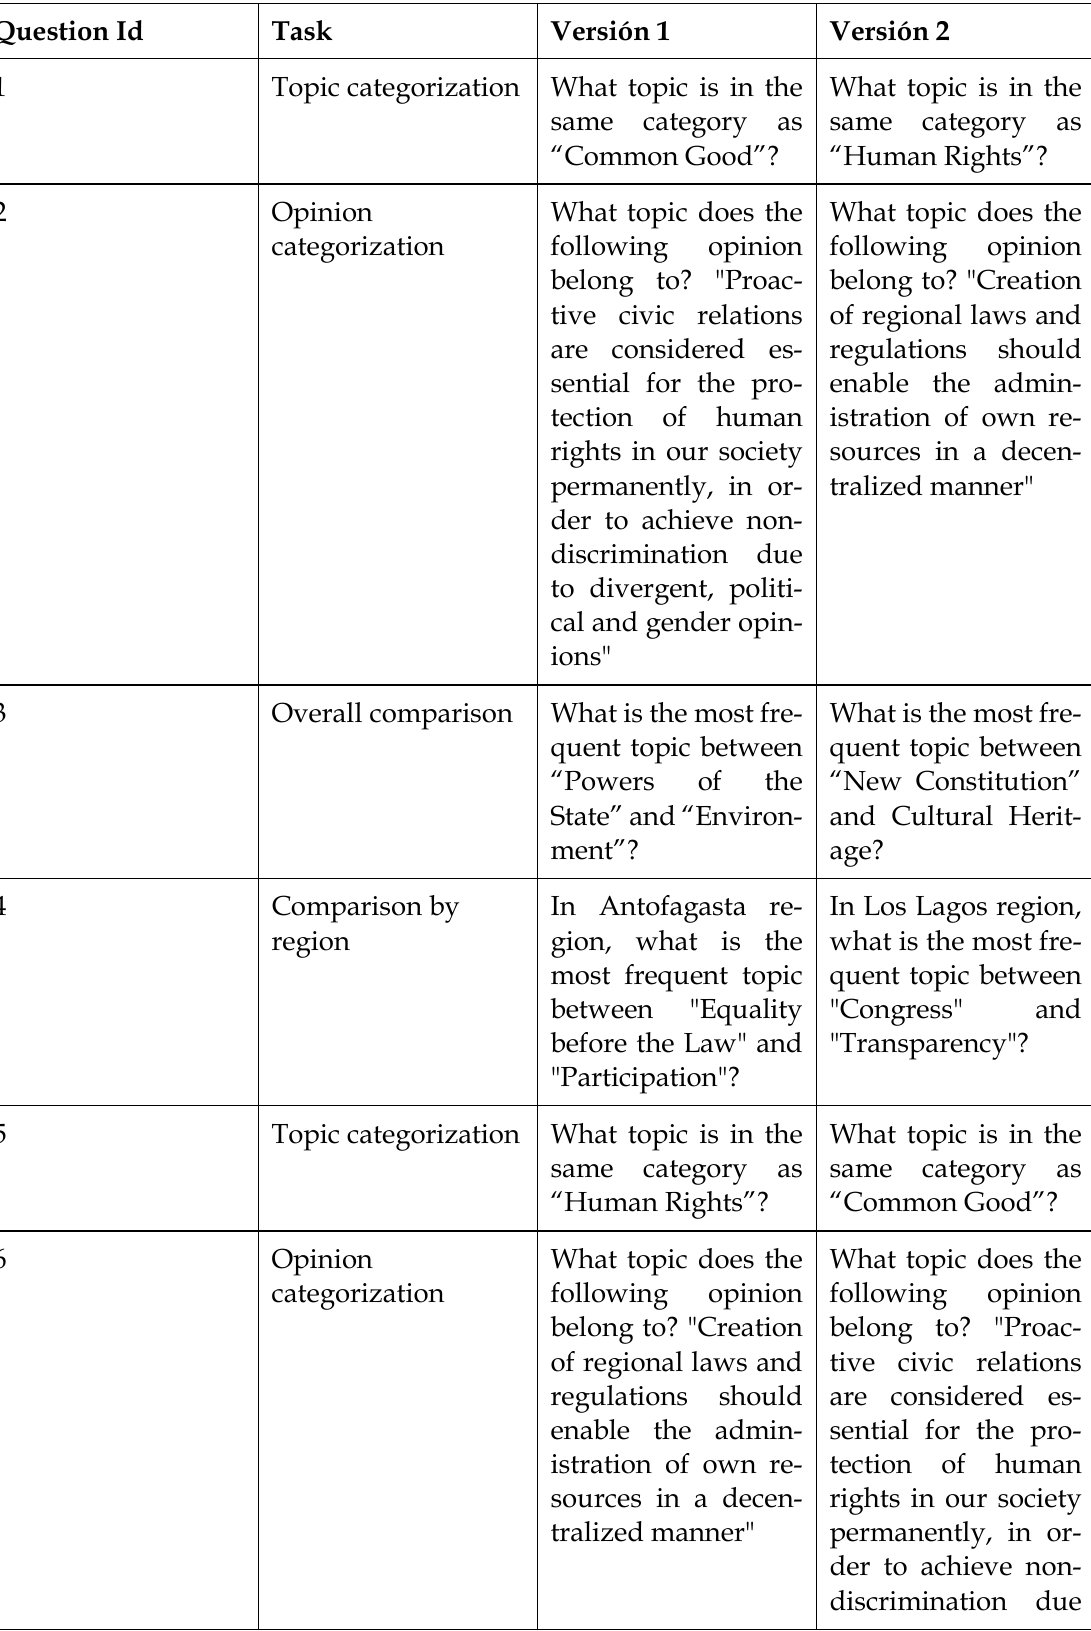
Table C1: Questions by task and version Question